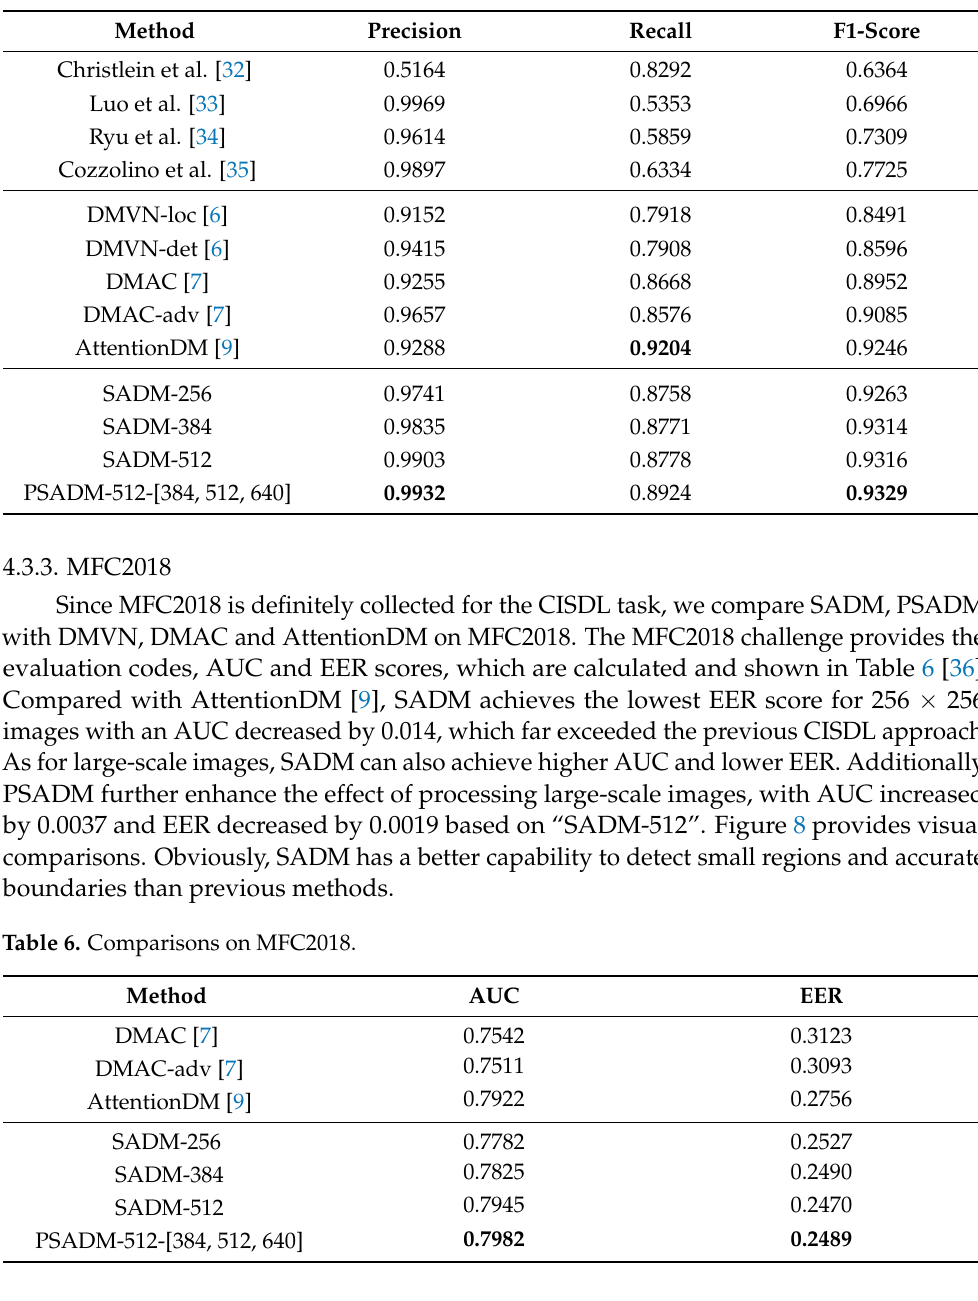
Table 5. Comparisons on the paired CASIA dataset.